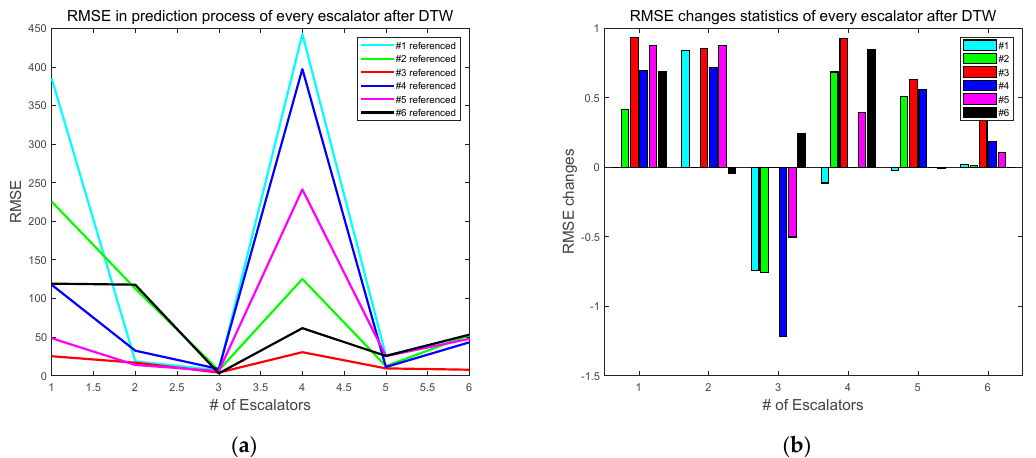
Figure 18. Statistics of RMSE in prediction process. ( a ) RMSE of every escalator after DTW. ( b ) RMSE variation statistics after